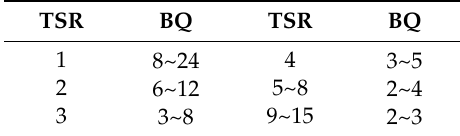
Figure 4. Turbine of Zhejiang University.